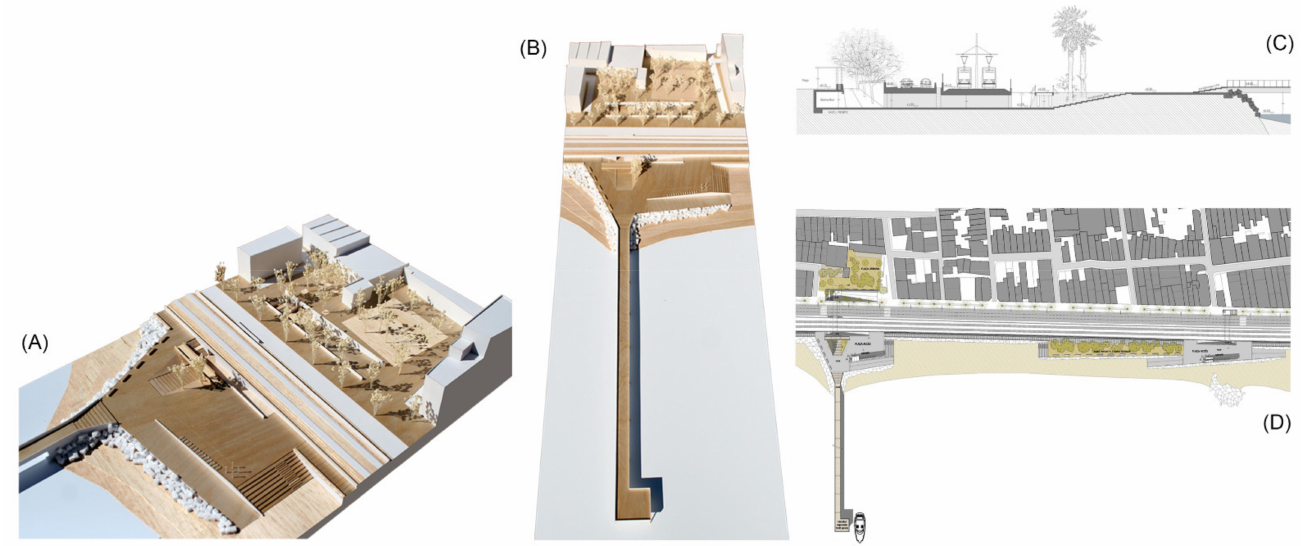
Figure 9. Urban and architectural project for the case study of downtown Premi à de Mar (Source: authors’ own). ( A , B ) Model pictures of the dock and public squares. ( C ) Transversal section through an underground passage. ( D ) General floorplan with the urban and landscape squares, a lightweight dock and a seaside